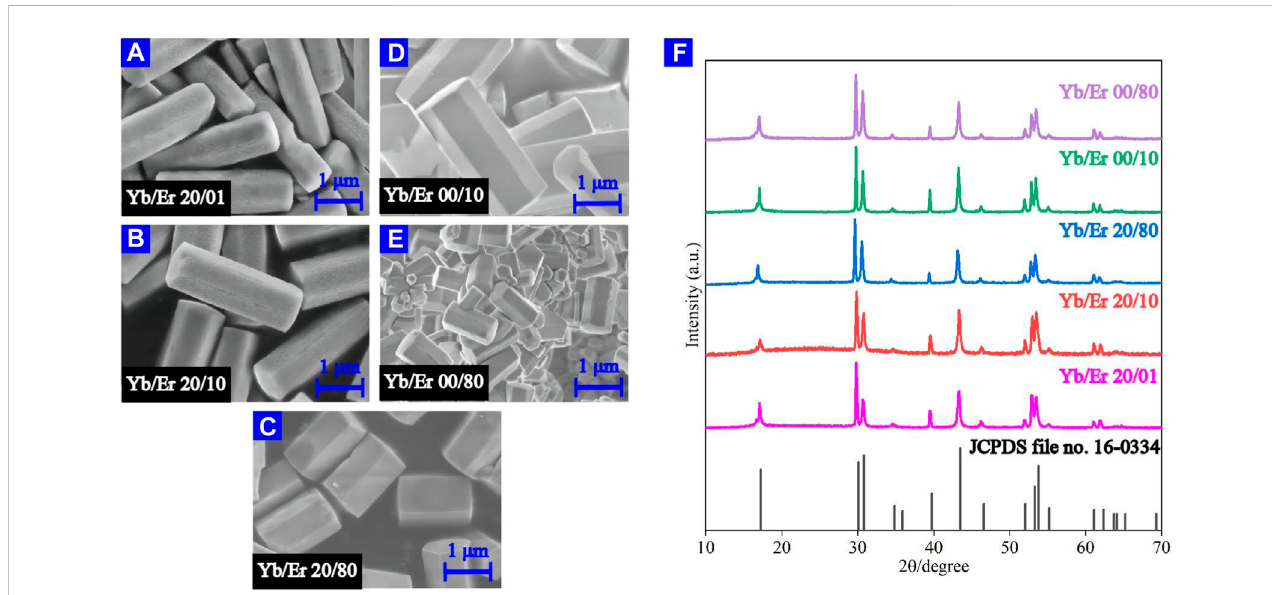
FIGURE 1 (A – E) SEM micrographs of β -NaYF 4 :Yb/Er MCs. (F) XRD patterns of the measured β -NaYF 4 :Yb 3+ /Er 3+ MCs compared to the standard JCPDS fi le no.16- 0334.